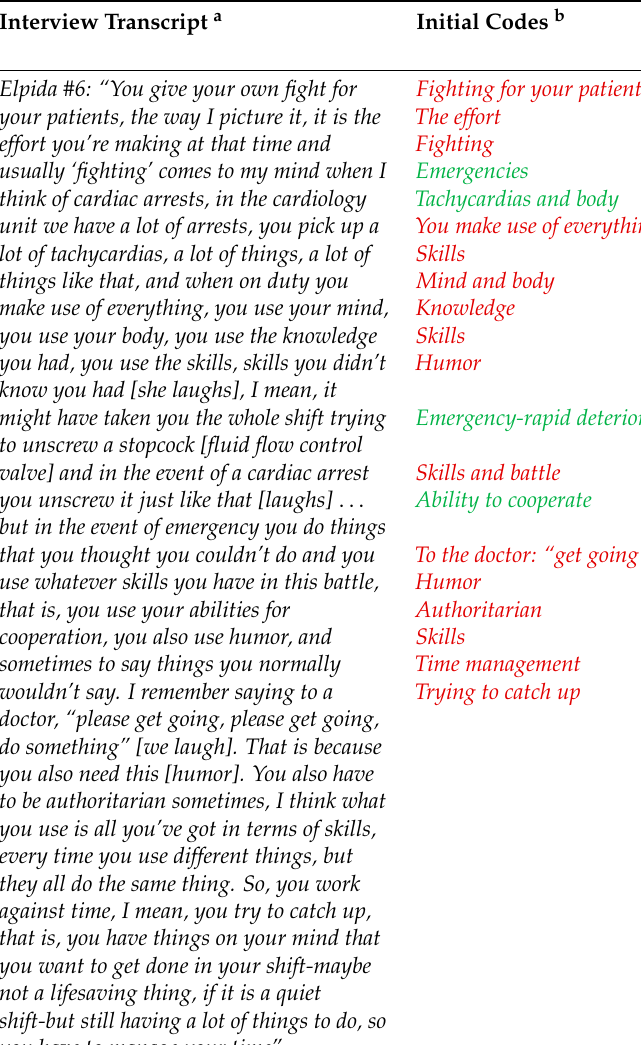
Table 3. An example that illustrates the stages of thematic analysis with operational